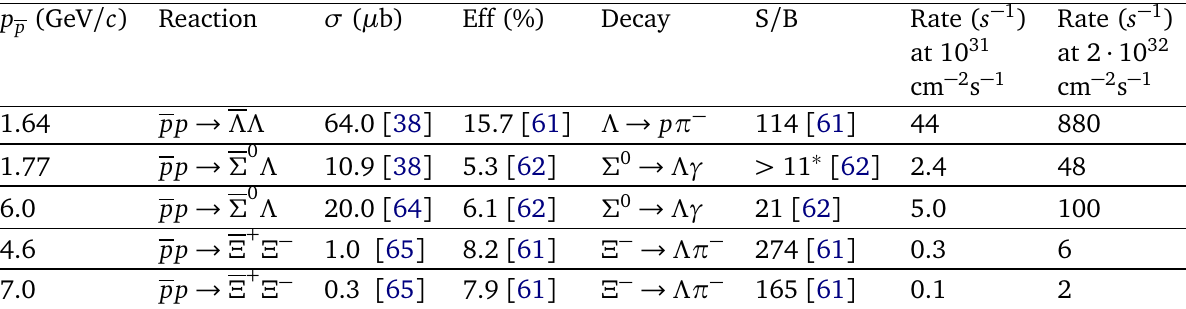
Table 1: Results from simulation studies of the various production reactions of ground state hyperons [ 61,62 ] . The efficiencies are for exclusive reconstruction, i.e. consid- ering all final state particles. The S / B denotes signal-to-background ratio and the asterisk * the upper limit of a 90% confidence